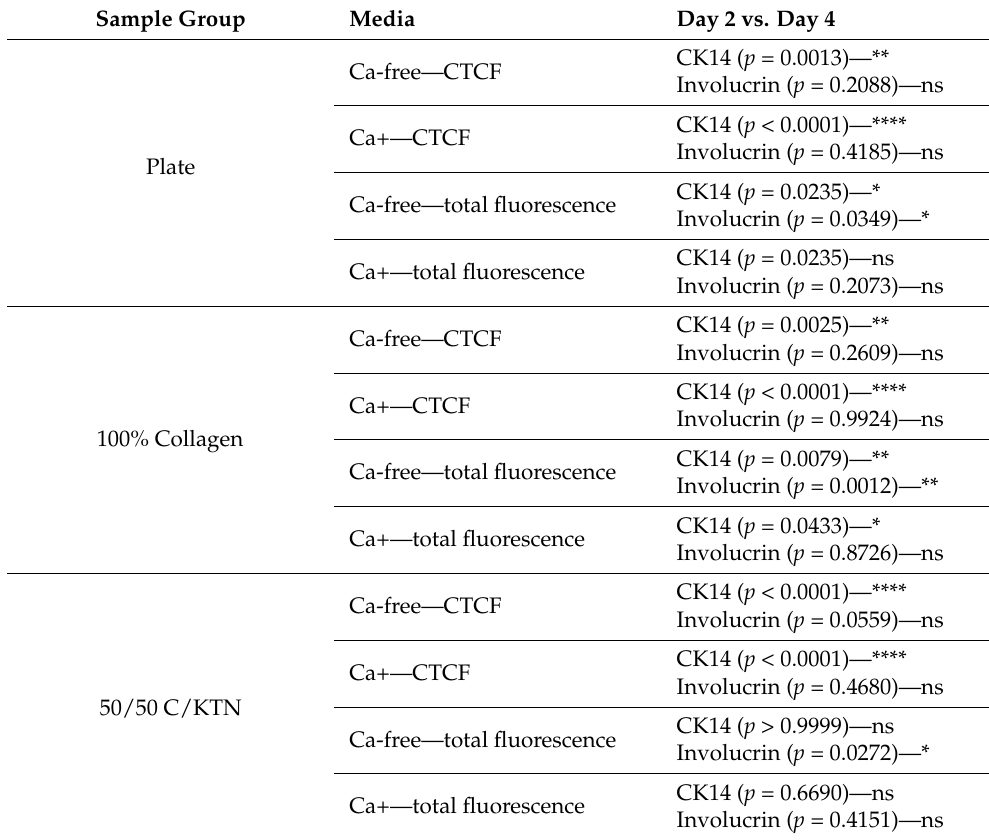
Table 4. Comparison of fluorescence intensity of differentiation markers between time points within each group. Two-way ANOVA was performed with n = 4 with 3 separate experiments. * = p <